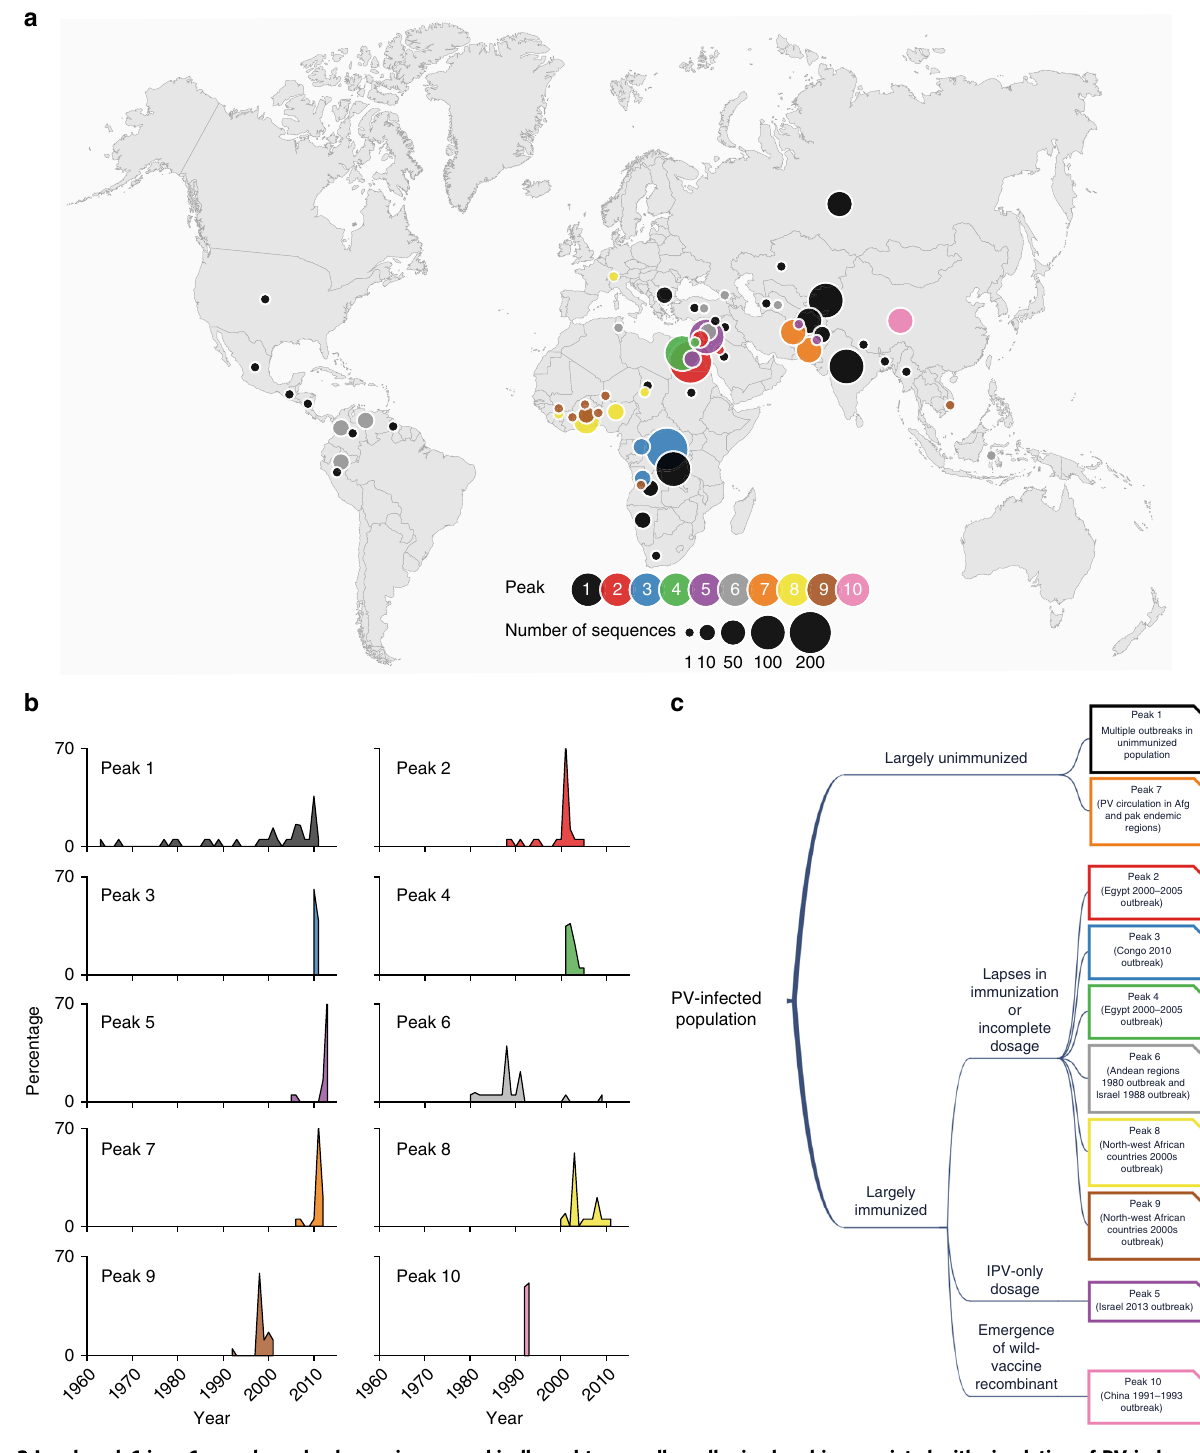
Fig. 3 Local peak 1 in vp1 prevalence landscape is geographically and temporally well-mixed and is associated with circulation of PV in largely unimmunized populations. a Geographical location of sequences that correspond to each peak. Only the sequences belonging to the 10 most populated peaks (~86% of the total sequences) are shown in the plot. The world map was adapted from the image available at https://freedesign fi le.com/139591- simple-world-maps-vector-material-05/ which is licensed under a Creative Commons Attribution license. b The temporal distribution of the sequences in each of the 10 most populated peaks. Each sub fi gure plots the percentage of sequences in a particular peak with respect to the sampling year. The peaks are colored according to the scheme speci fi ed in a . c Association of local peaks in the landscape with largely unimmunized or immunized population based on the literature associated with the available sequence data. The outline of boxes (representing peaks) is colored according to the scheme speci fi ed in a